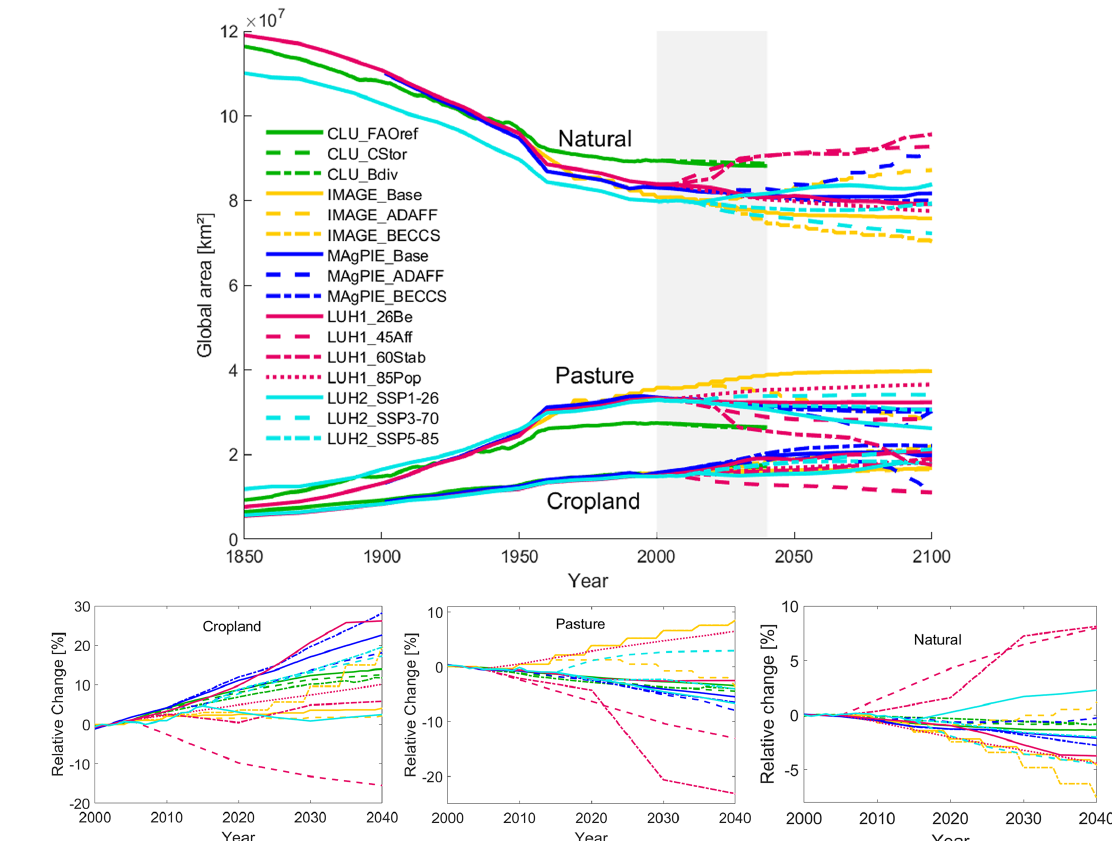
Figure 1. Absolute land area of croplands, pastures and natural areas between 1850 and 2100 for 16 scenarios of five land-use models, and the detailed relative changes in LU from 2000 to 2040 analyzed in this